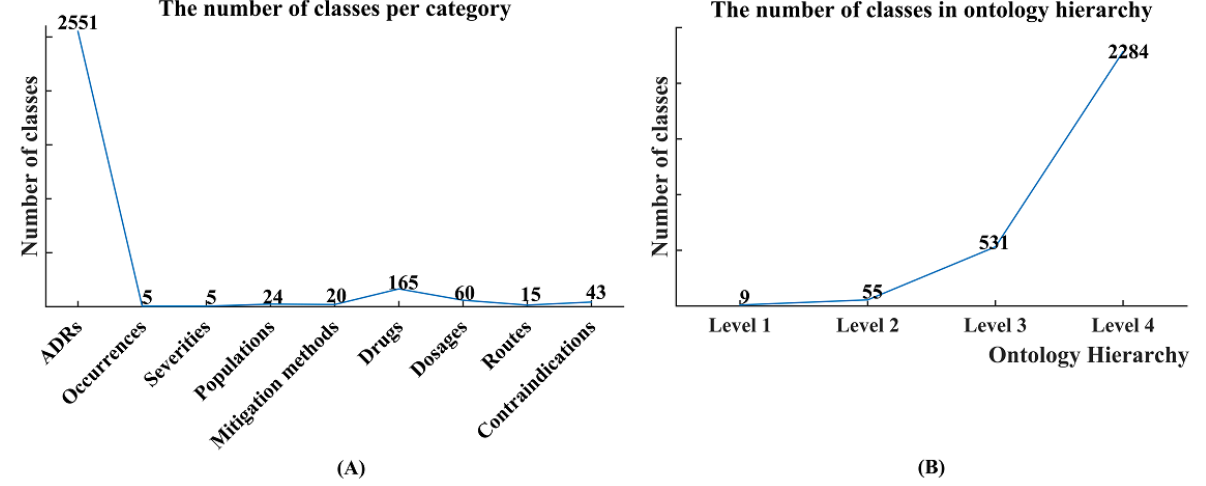
Figure 3. Statistics of the classes in ADRs ontology. ADRs: adverse drug reactions.